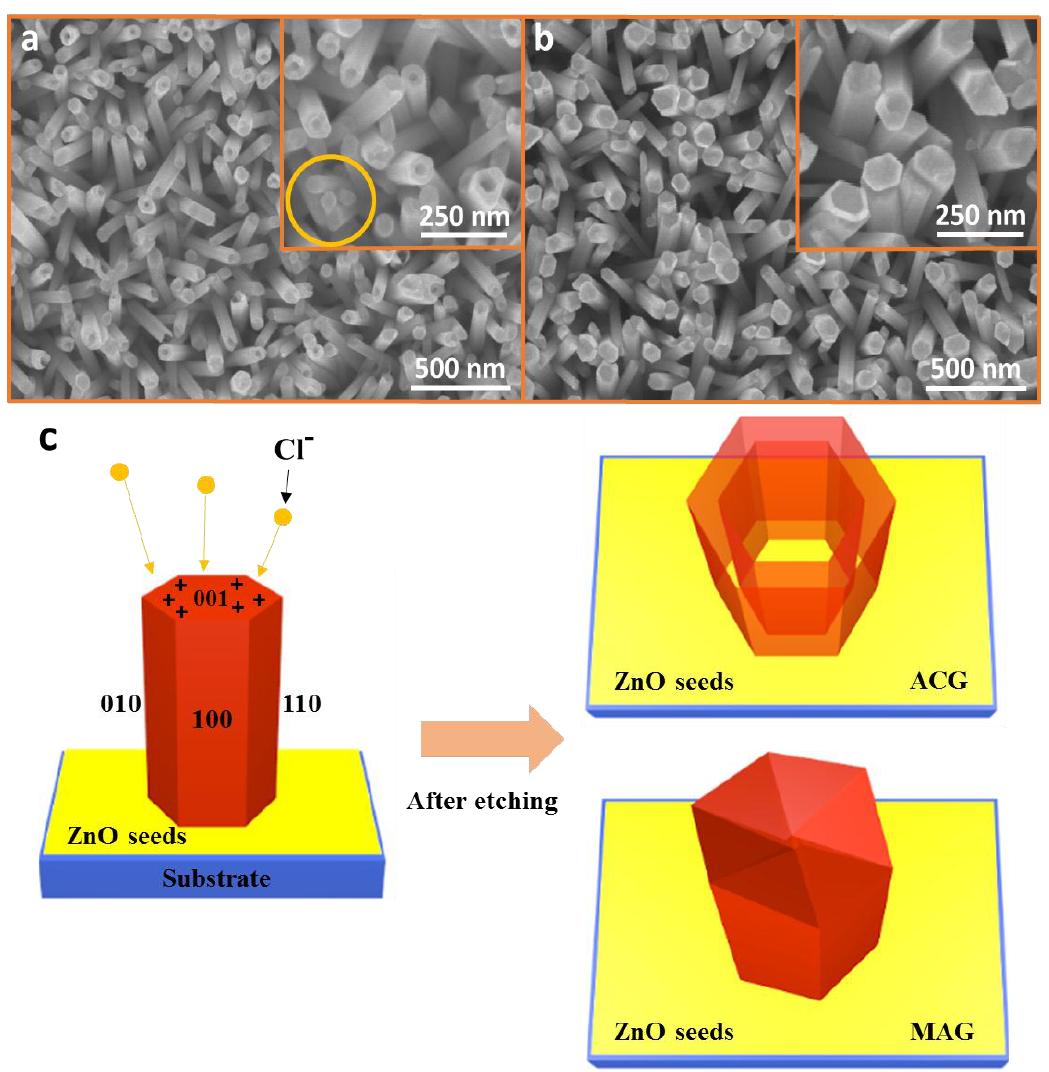
Figure 4. SEM images of ZnO nanotubes (ZNTs) (inset: magnified image), formed via defect-centric etching of ZNRs grown with ( a ) ACG and ( b ) MAG methods; ( c ) Etching mechanism for ACG and MAG ZNRs.